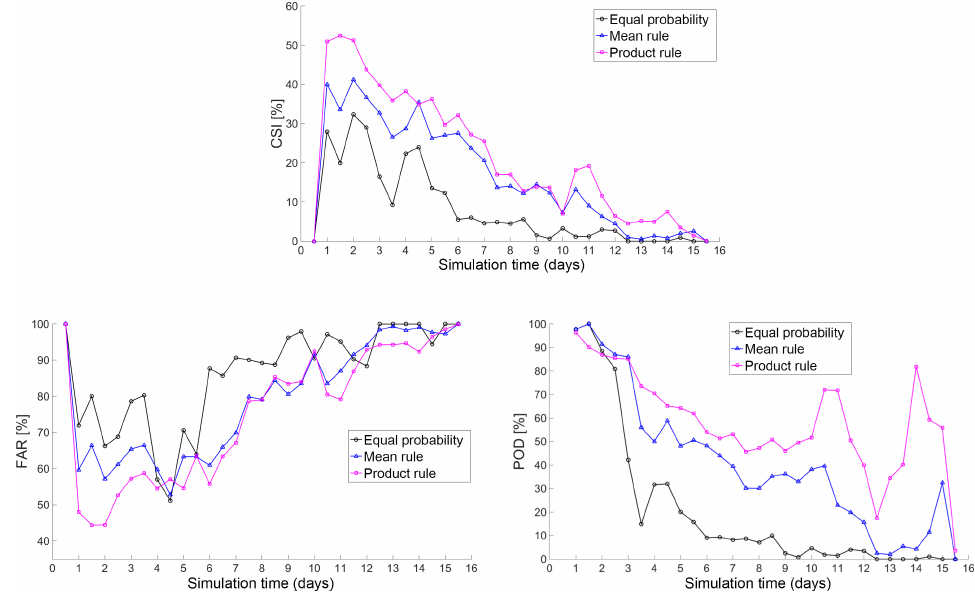
Figure 10. Comparison of the critical success index (CSI), the false alarm rate (FAR), and the probability of detection (POD) time series during 12h time intervals obtained by applying the equal-probability strategy, the mean rule, and the product